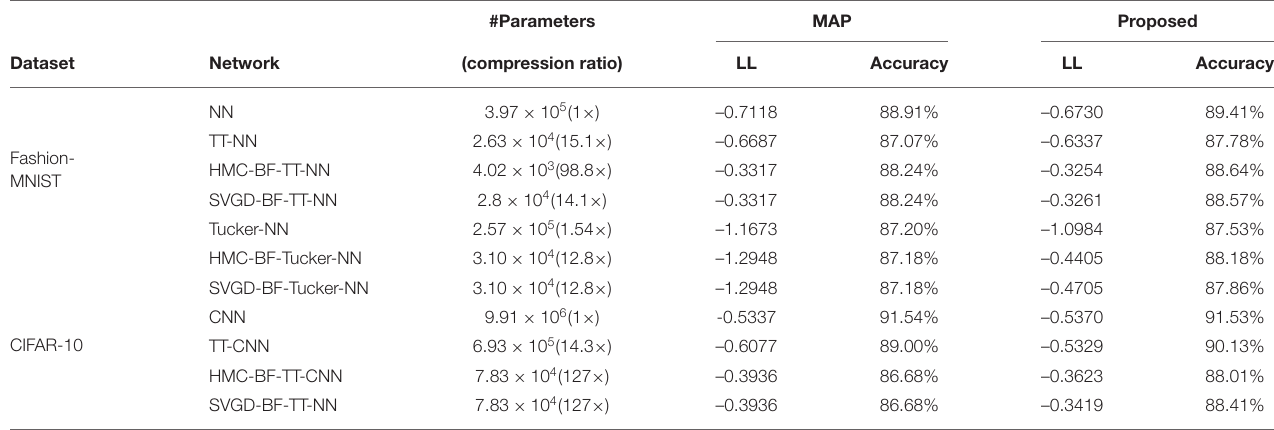
TABLE 3 | Results of different networks on two